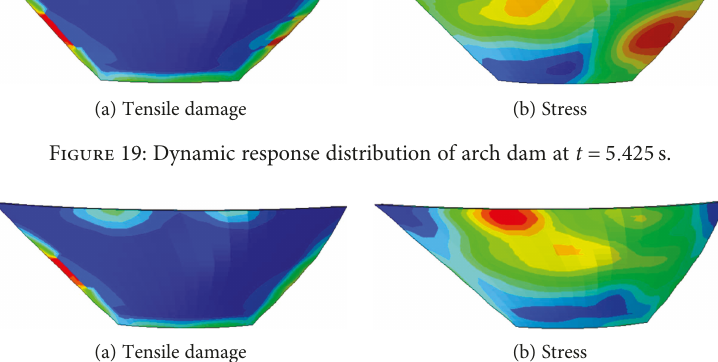
Figure 20: Dynamic response distribution of arch dam at t = 8 087 s